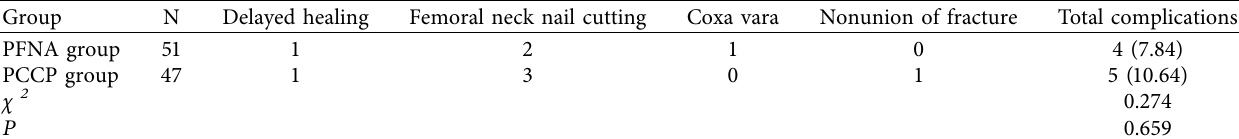
Table 3: Comparison of postoperative indicators between the two groups ( x ± s , n � 98). Table 4: Comparison of postoperative complications between the two groups ( n , %).